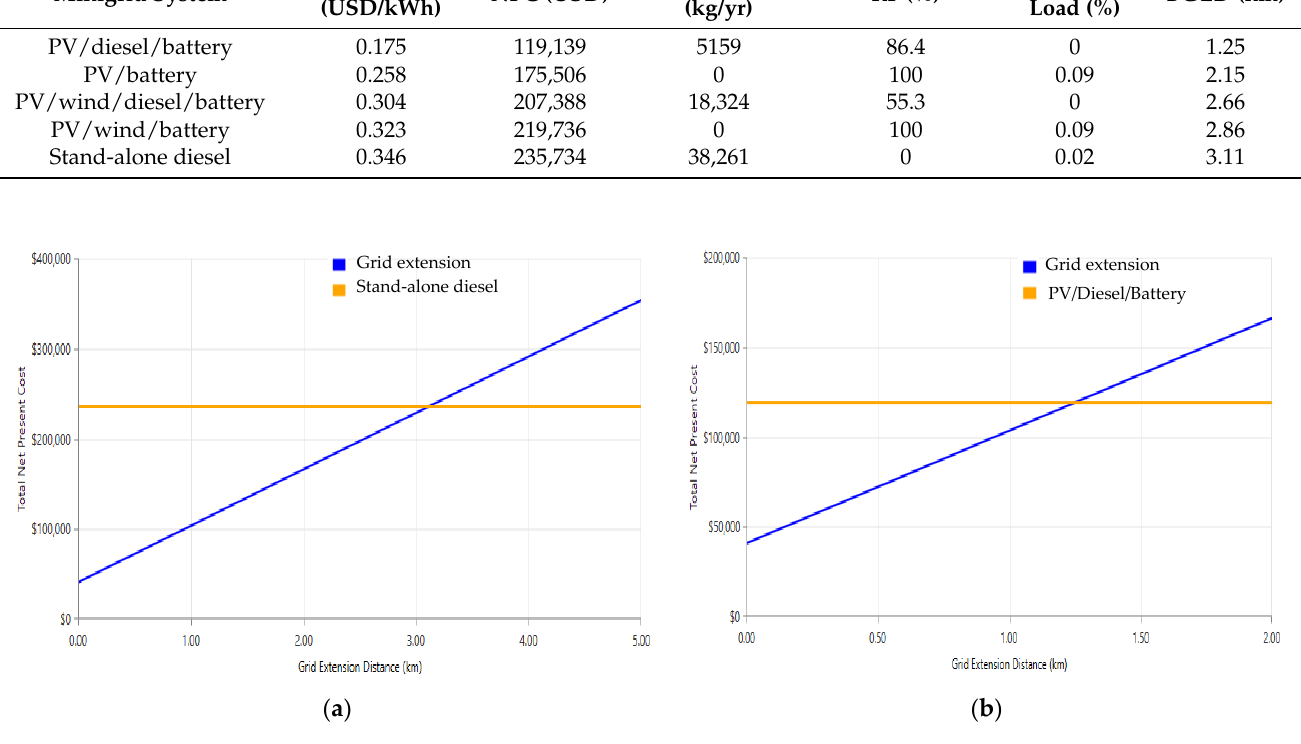
Figure 10. BGED relative to ( a ) Stand-alone diesel system, ( b ) PV/Diesel/Battery system. Table 3. Possible configurations for the selected site.